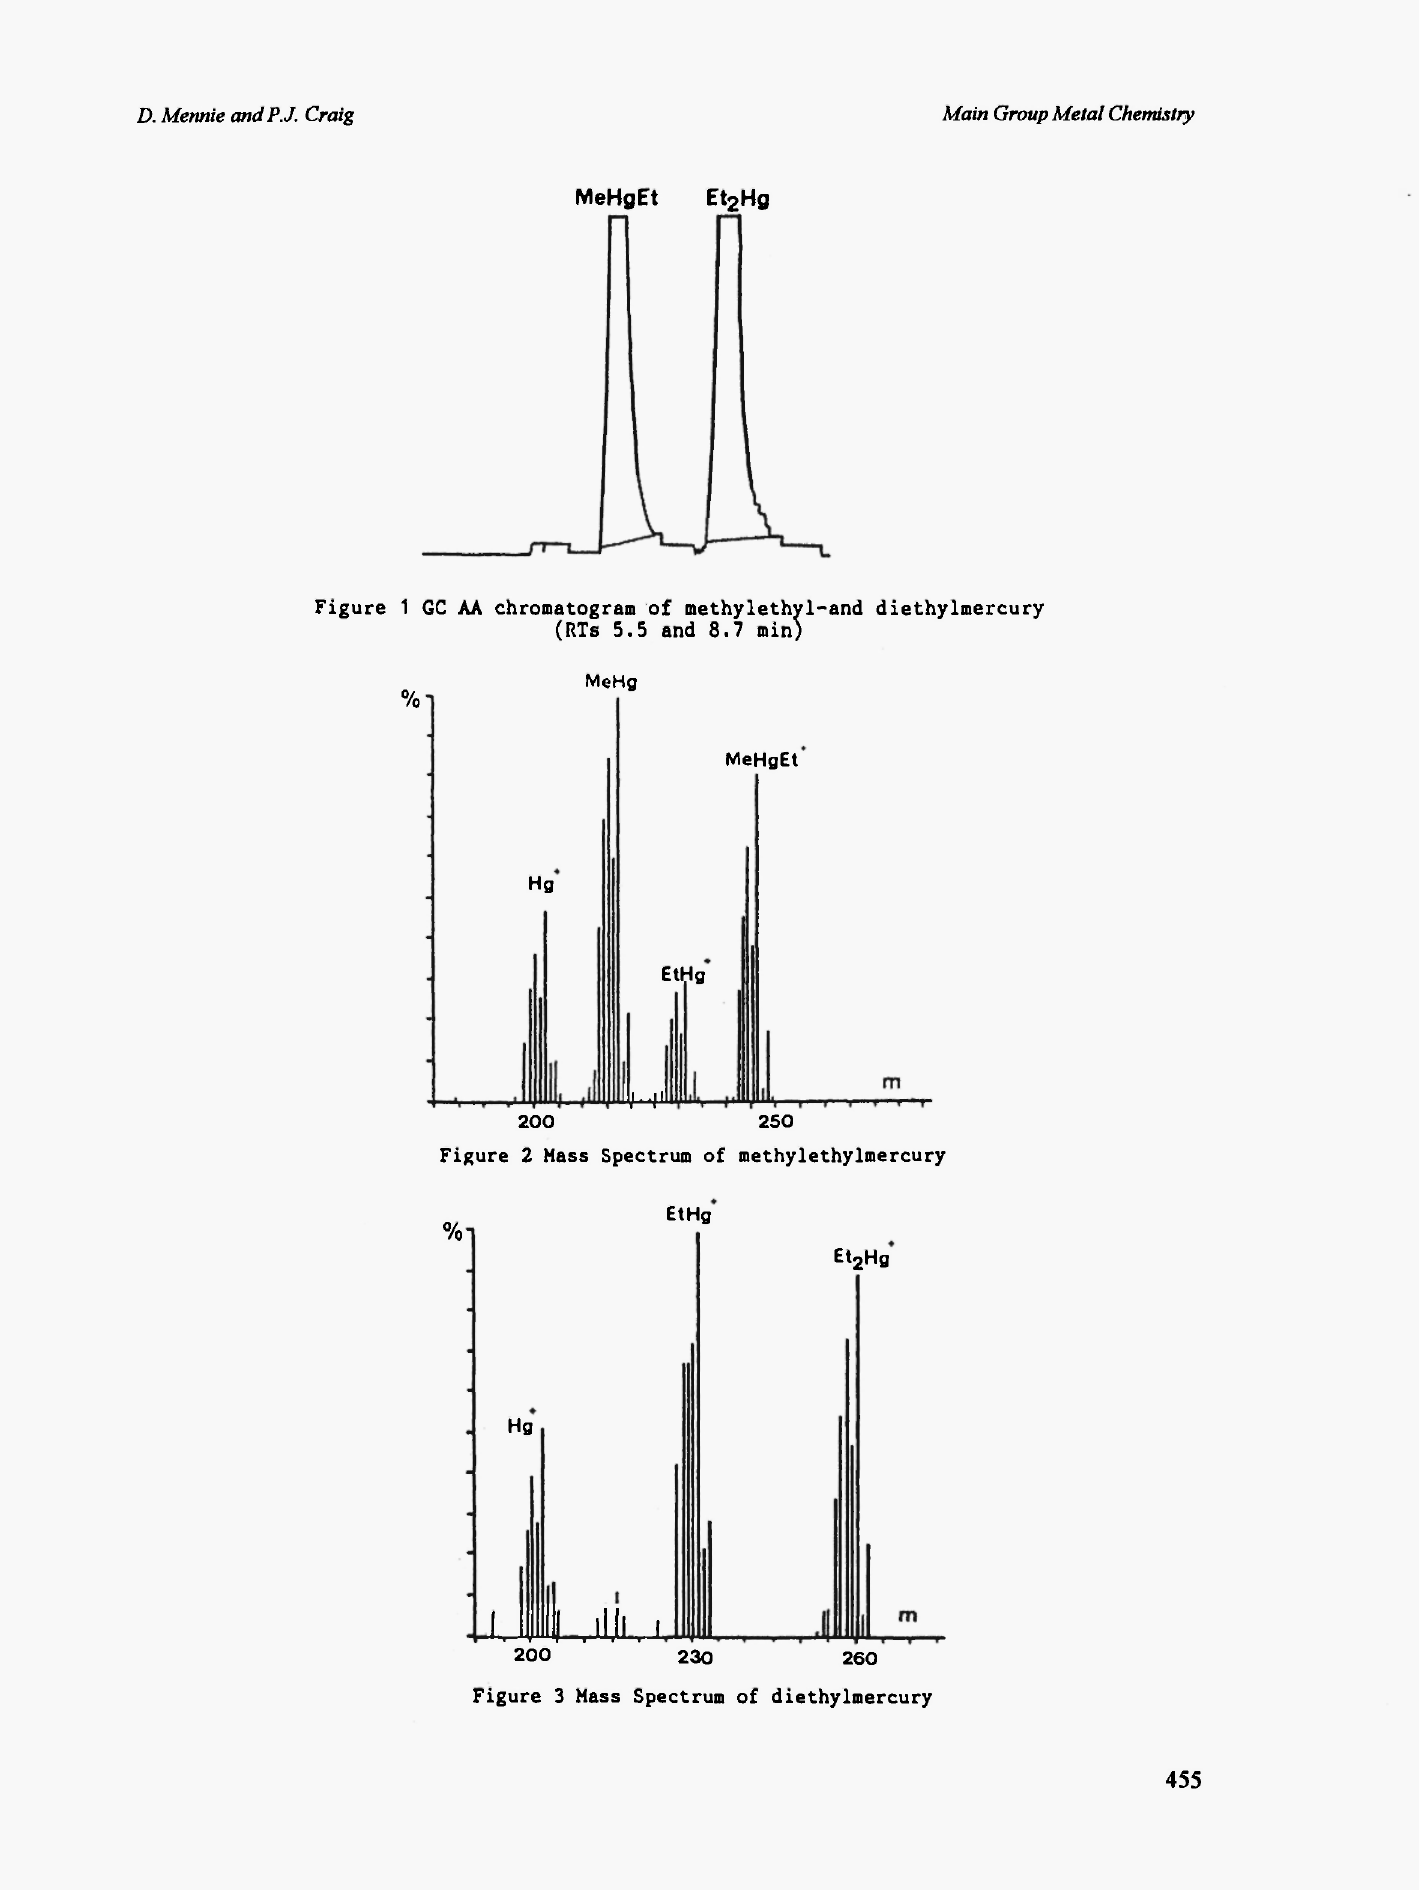
Figure 1 GC AA chromatogram of methylethyl-and diethylmercury (RTs 5.5 and 8.7 min)